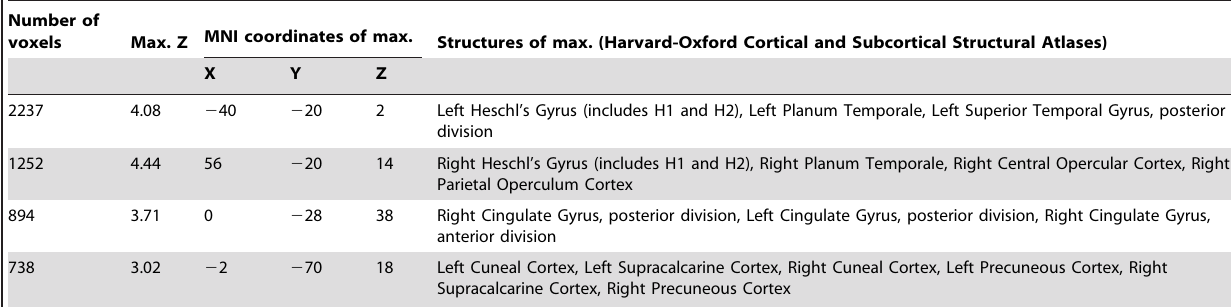
Table 6. Voxel-wise statistical comparison of EEG-informed High (90 and 100 dB) vs. Low (70 and 80 dB).